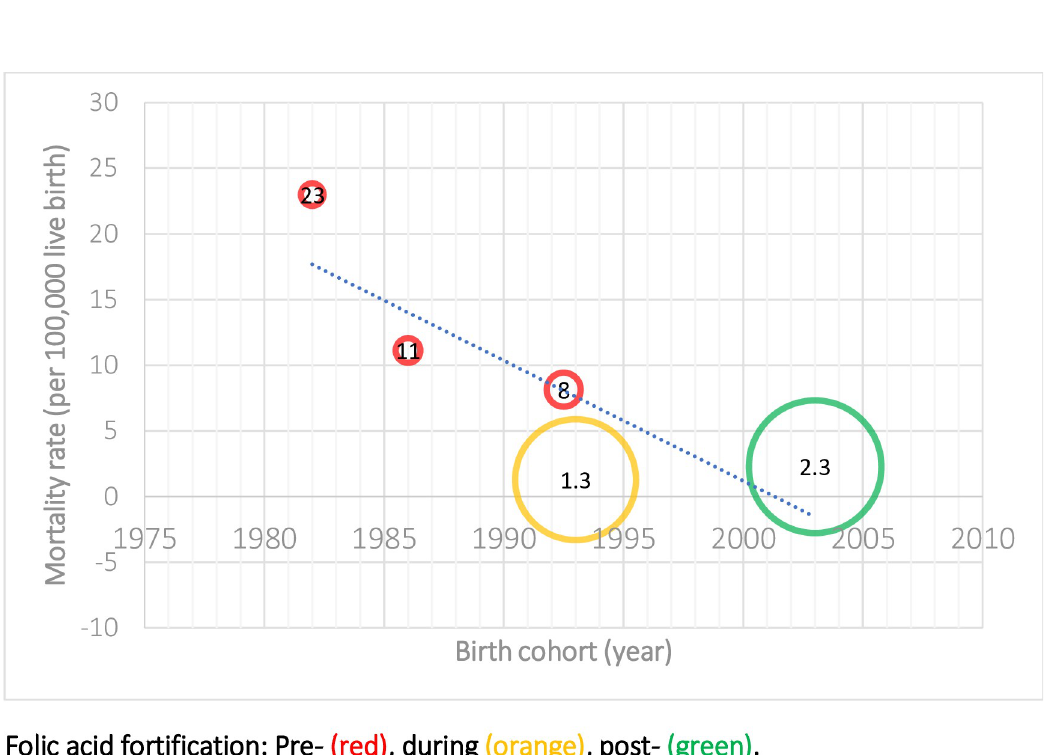
Fig 3. Infant mortality from spina bifida in the U.S. and Canada (Birth cohort: 1982–2003) [3,30,33,34].